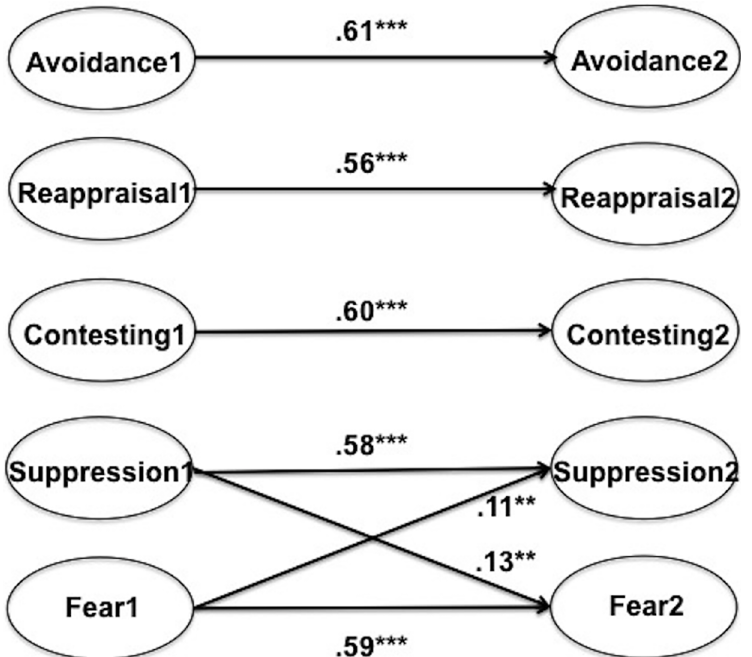
Fig 3. Final model with standardized regression weights. Not shown are correlations among the exogenous variables, correlations among the disturbance terms, or correlated item residuals across waves. (cid:3) p < .05. (cid:3)(cid:3) p < .01. (cid:3)(cid:3)(cid:3) p <